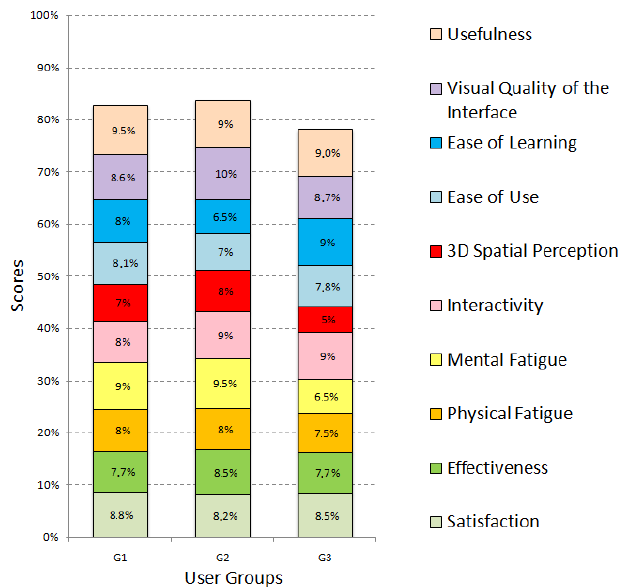
Fig. 17: User-based evaluation (qualitative